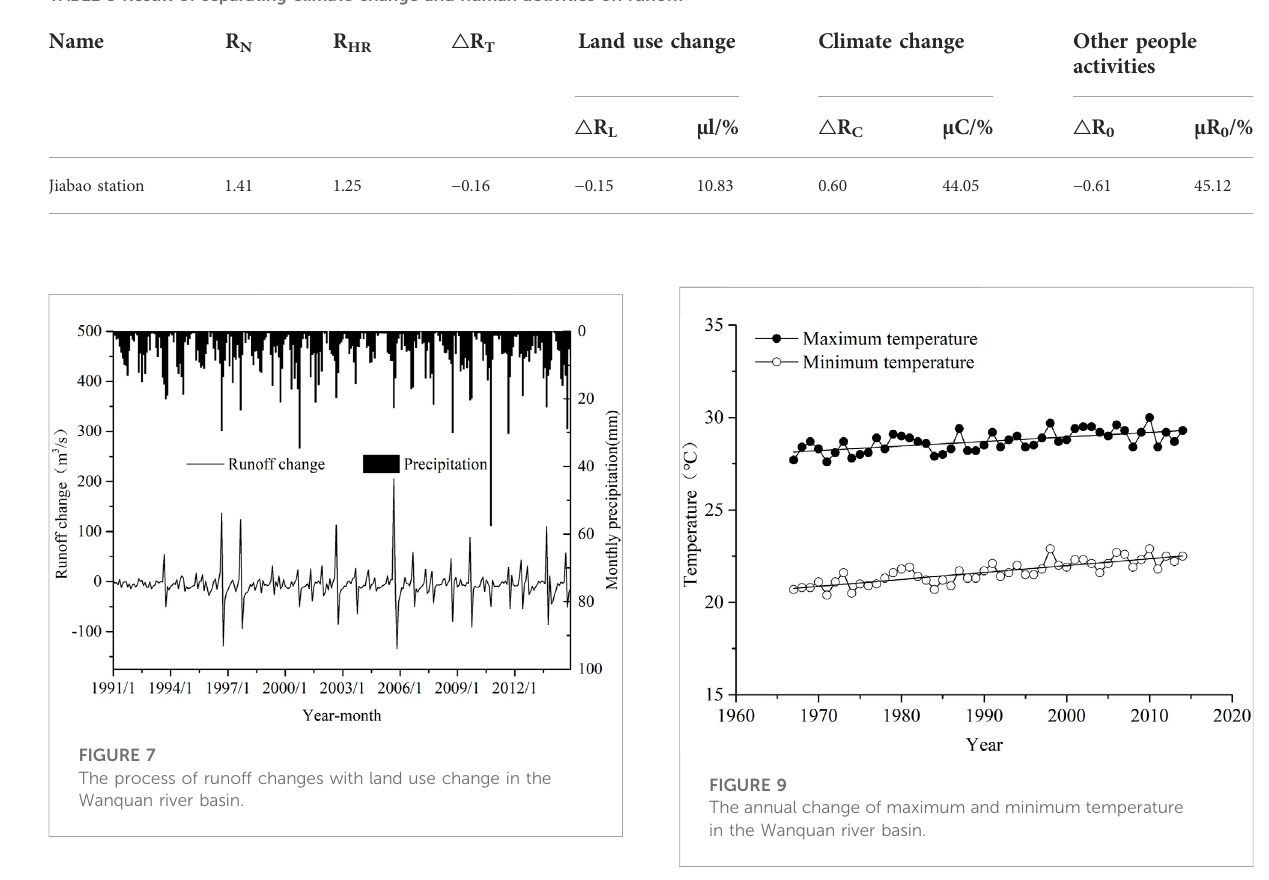
TABLE 5 Result of separating climate change and human activities on runoff.